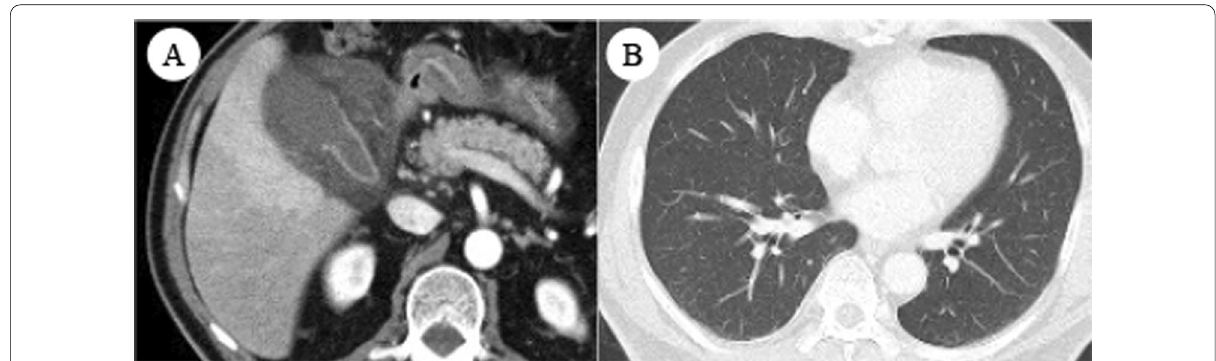
Fig. 1 A Contrast-enhanced computed tomography revealed specific findings of gangrenous cholecystitis, including intraluminal membranes, an irregular or absent wall, and abscess formation. B Chest computed tomography showed no evidence of